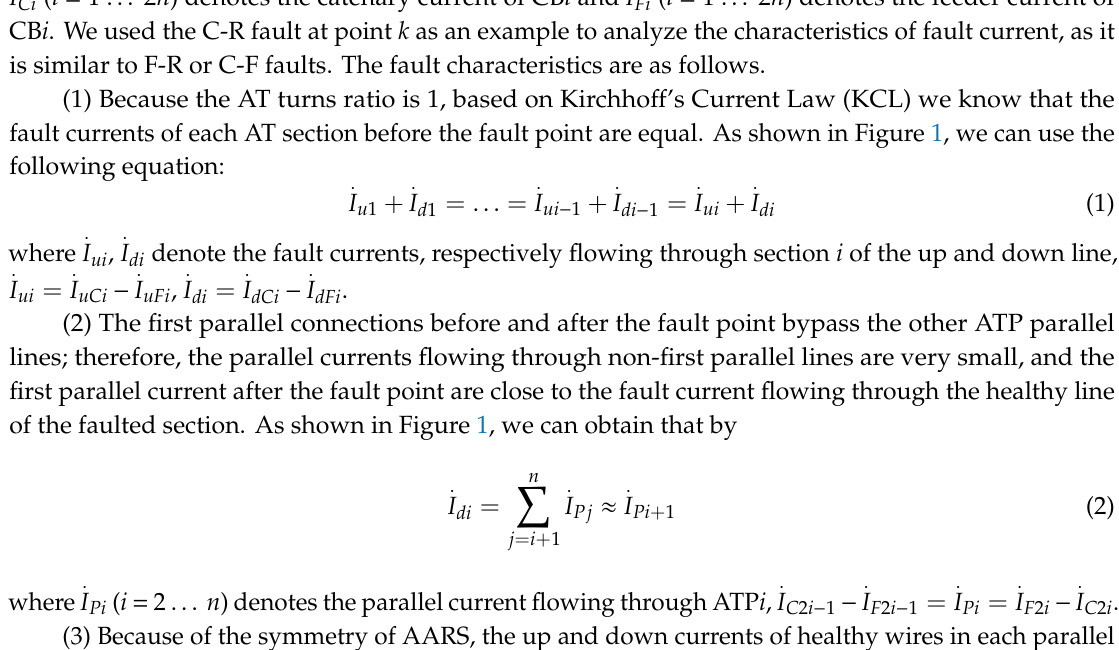
I  ( i = 1…2 n ) denotes the feeder current of Ci